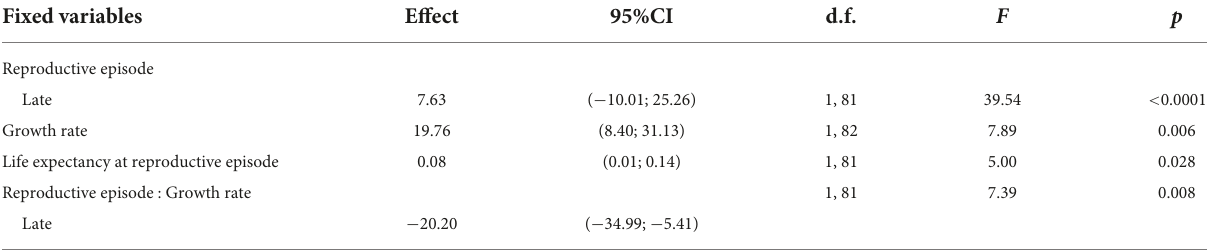
TABLE 1 Linear mixed model analyzing the number of eggs laid by Tenebrio molitor